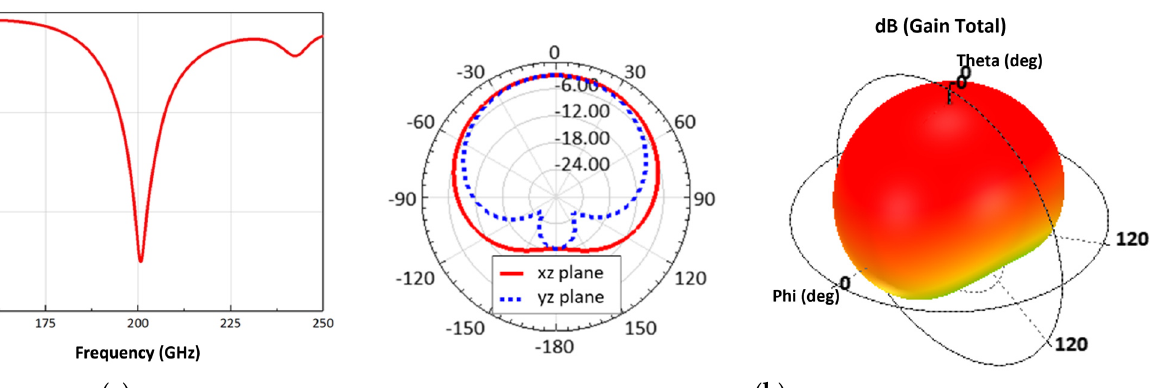
Figure 5. Three-dimensional electromagnetic simulation results of the folded dipole on-chip an- tenna: ( a ) Reflection coefficient. ( b ) Radiation pattern for indicating the gain and 3-dB beamwidth.